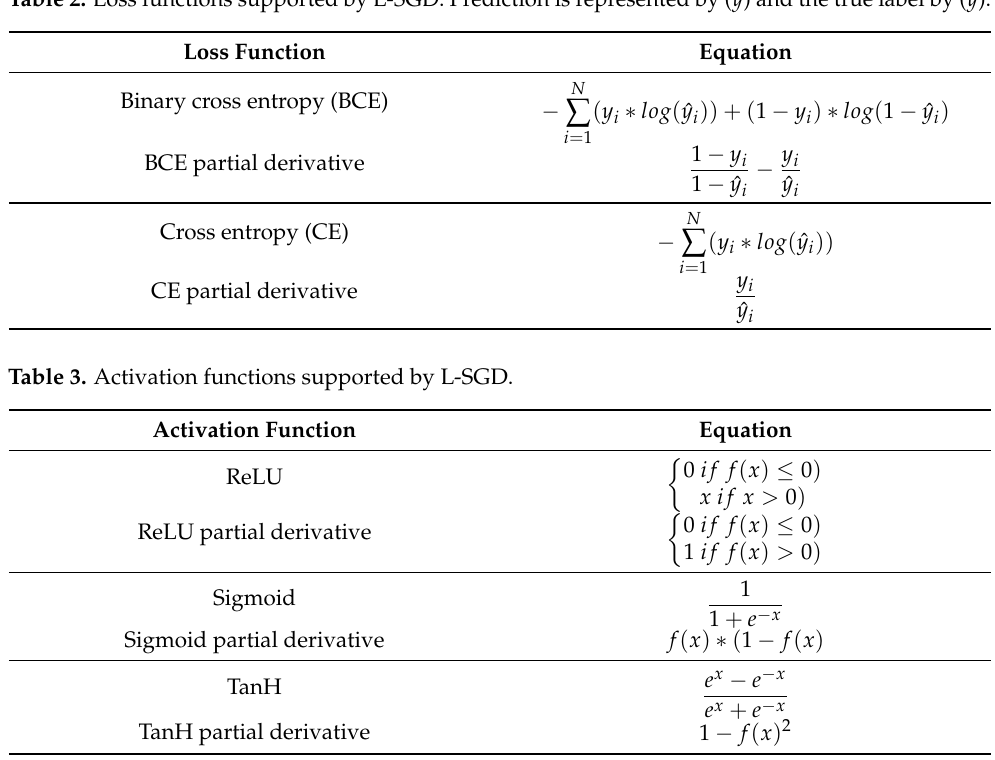
Table 2. Loss functions supported by L-SGD. Prediction is represented by ( ˆ y ) and the true label by ( y ).